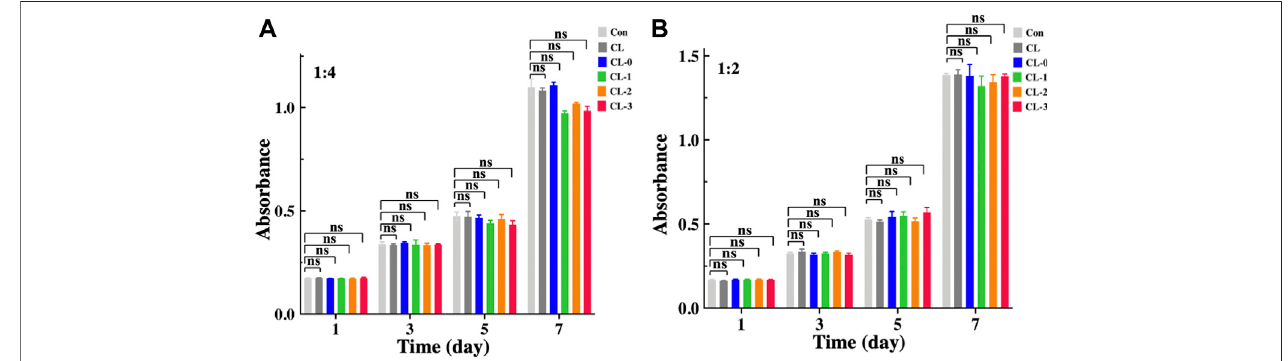
FIGURE6| Cytotoxicityand proliferationactivities ofthecontact lenses onhumancornealepithelialcells(HCECs).Cell counting kit-8analysisofHCECs seeded in the contact lenses extracts with a concentration of 1:4 (A) and 1:2 (B) , n (cid:2) 3.